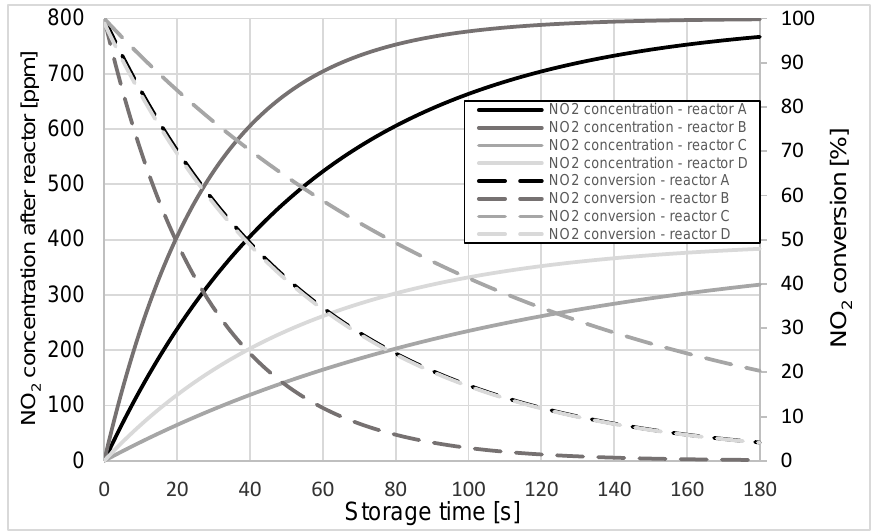
Figure 3 . Changes in NO 2 concentration and its conversion during the storage process in A, B, C, and D reactors at the operating temperature of 200 °C .